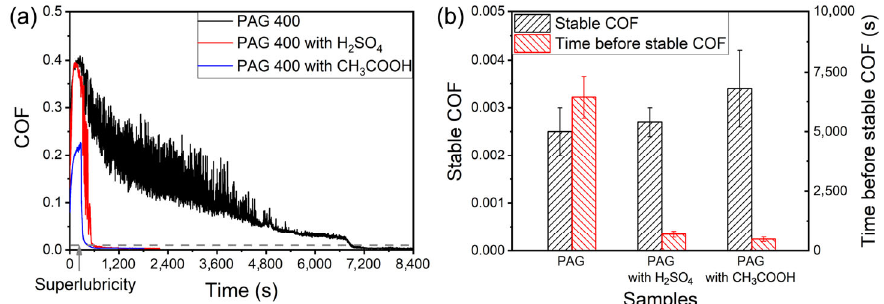
Fig. 1 (a) Evaluation of friction coefficient with time, and (b) time for realizing stable COF and final diameters of the worn region when lubricated by original PAG aqueous solutions and PAG aqueous solutions with acids at pH of